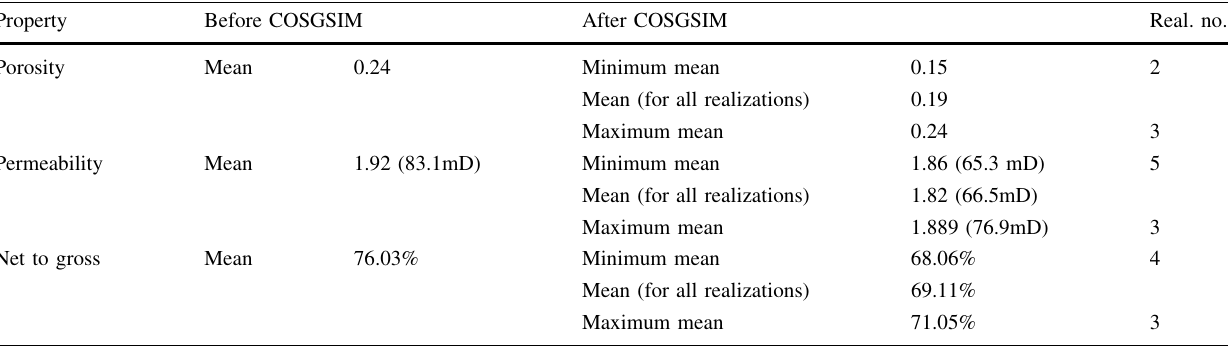
Table 3 Summary of the statistical means before and after building realizations Property Real.